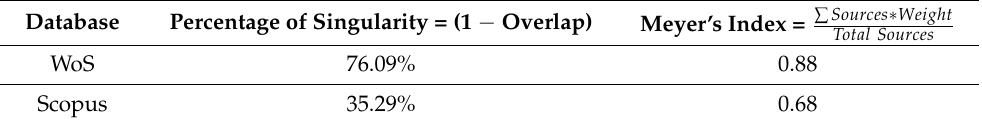
Table 2. Single articles of WoS and